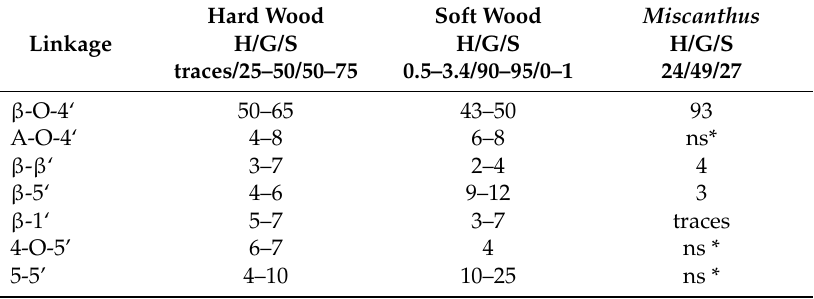
Table 1. Abundance of linkages in lignins of soft and hard wood [61] and Miscanthus grasses [62,63] including KOH-extractable and non-KOH-extractable in